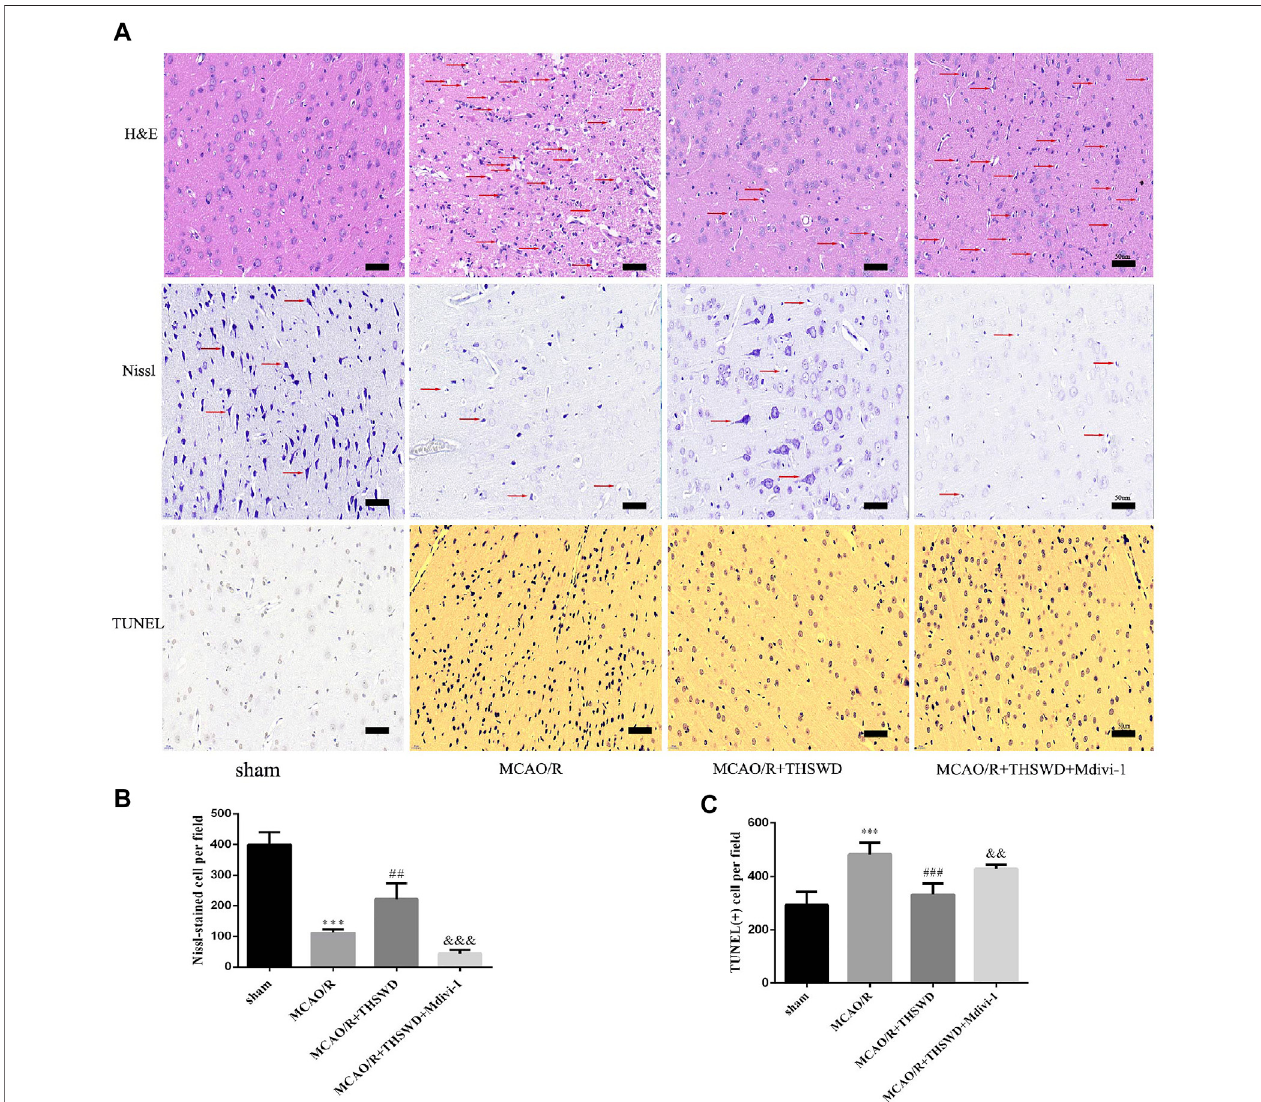
FIGURE 2 | Effect of THSWD on the survival and apoptosis of neuronal cells. (A) H&E, Nissl and TUNEL staining (×400). Scale bar = 50 μ m. Red arrows in H&E stainingshowneuronalcytoplasmicsparseness,edema,andnuclearsequestration;redarrowsinNisslstainingmarkdifferentNisslbodiesordegeneratingneurons. (B) Quanti fi cation of Nissl vesicles; n = 4 per group. (C) Quanti fi cation of TUNEL-positive cells; n = 5 per group. *** p < 0.001 versus sham group, ## p < 0.01, ### p < 0.001 versus MCAO/R group, && p < 0.01, &&& p < 0.001 versus MCAO/R + THWSD group.